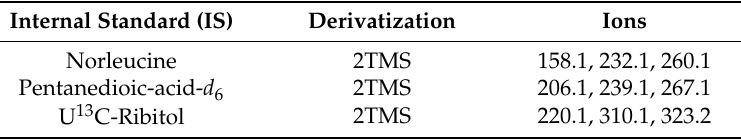
Table 4. Settings applied in SIM mode for internal